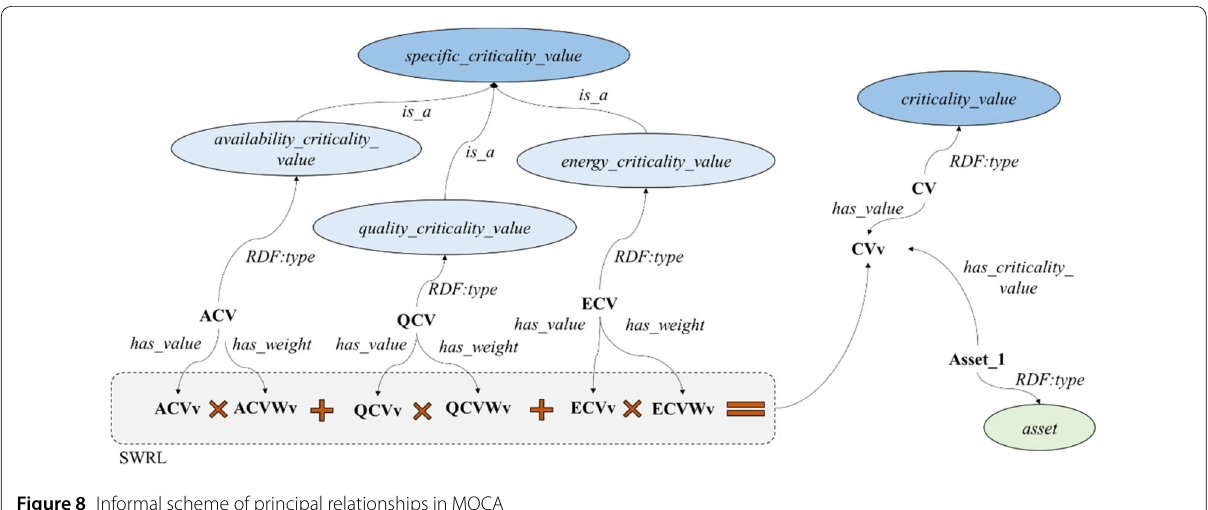
Figure 8 Informal scheme of principal relationships in MOCA